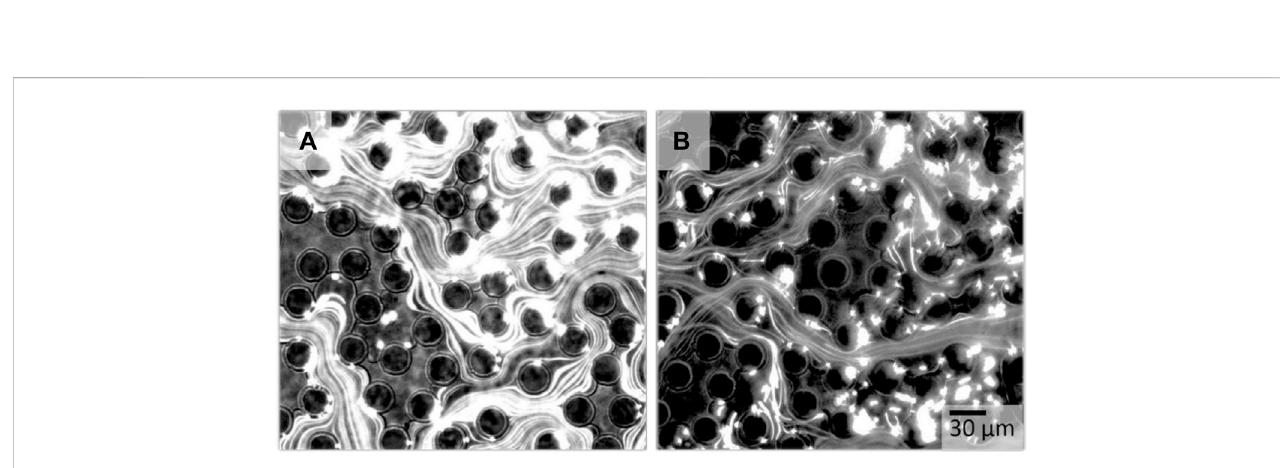
FIGURE 6 Path lines obtained by fl uorescence microscopy for an invading Newtonian glycerin solution, respectively viscoelastic polymer solution displacing dodecane. In (A) the Newtonian glycerin solution follows symmetrical the tortuous path lines of the porous medium, whereas the viscoelastic HPAM solution exhibits asymmetric and even crossing path lines in (B) , which represents an unsteady fl